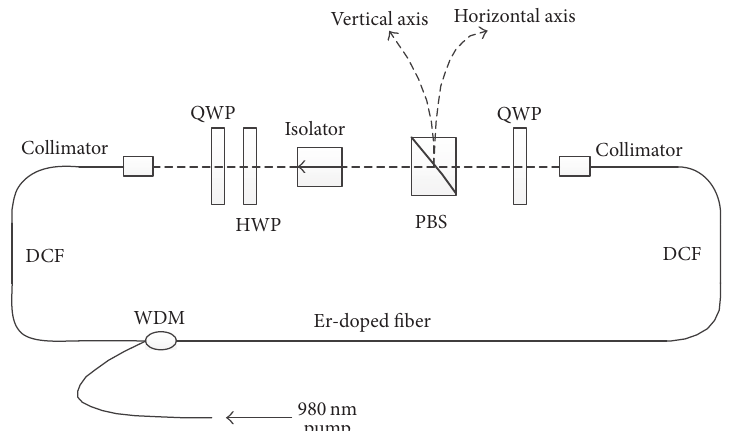
Figure 1: A schematic diagram of the all-normal dispersion fiber laser; PBS: polarization beam splitter; HWP: half waveplate; QWP: quarter waveplate; WDM: wavelength division multiplexer.